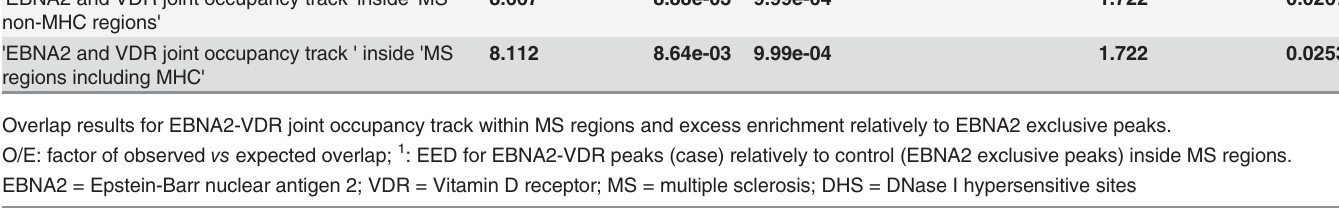
gions (performing the evaluation with or without the MHC region, as above): a significant en- richment (O/E without MHC = 8.667-fold, p = 8.88e-03; O/E with MHC = 8.112-fold, p = 8.64e-03) was found, even after controlling for DHSs track (Table 4). When performing a Table 4. EBNA2-VDR joint binding inside MS and other disease-associated regions. ANALYSIS